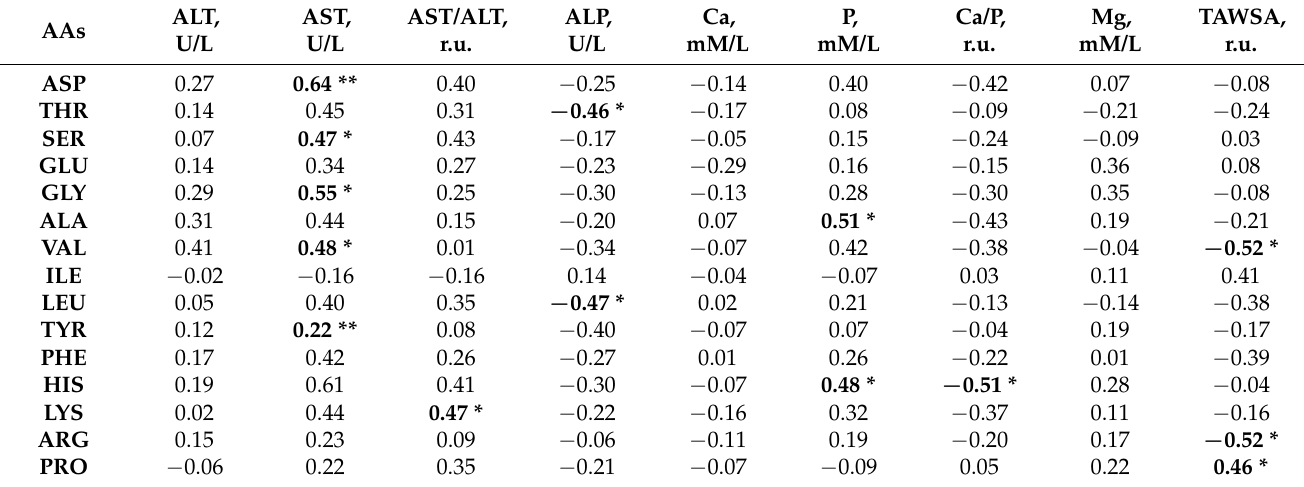
Table 7. The correlation coefficients between all obtained amino acids and the major biochemical parameters of the blood serum of Duroc pigs of group three (82 days): ALT, alanine aminotransferase; AST, aspartate aminotransferase; ALT/AST, alanine to aspartate aminotransferases’ ratio; Ca, calcium; P, phosphorus; Ca/P, calcium to phosphorus ratio; Mg, magnesium; TAWSA, total amount of the water-soluble antioxidants (n = 19).